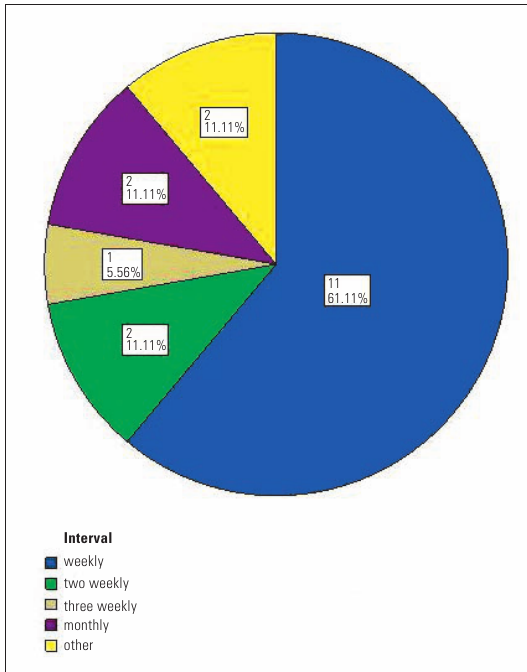
Figure 2 Interval of goal eval- uation (n =